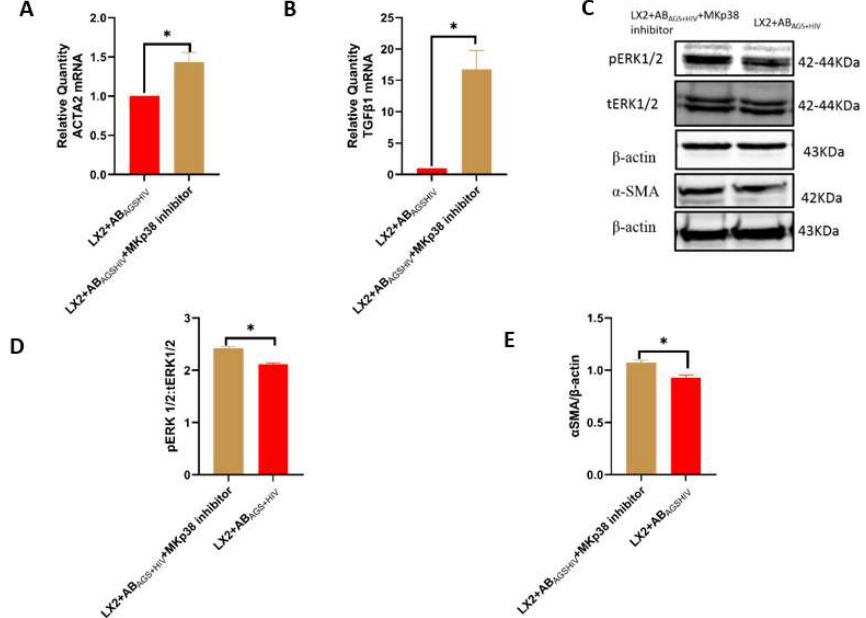
Figure A5. Pharmacological inhibition of p38 MAPK induces ERK activation followed by SMA deposition: RT-PCR quantification of: ( A ) ACTA2 and ( B ) TGF β 1. ( C – E ) Phopho-ERK1/2 and α -smooth muscle actin were measured by immunoblot analysis and the quantification of immunoreactive blots. Equal amounts of protein (20 µ g) were loaded in each lane. β -actin was used as an internal control. Data are from 3 independent experiments presented as mean ± SEM. Bars with * indicate significant difference ( p ≤ 0.05).